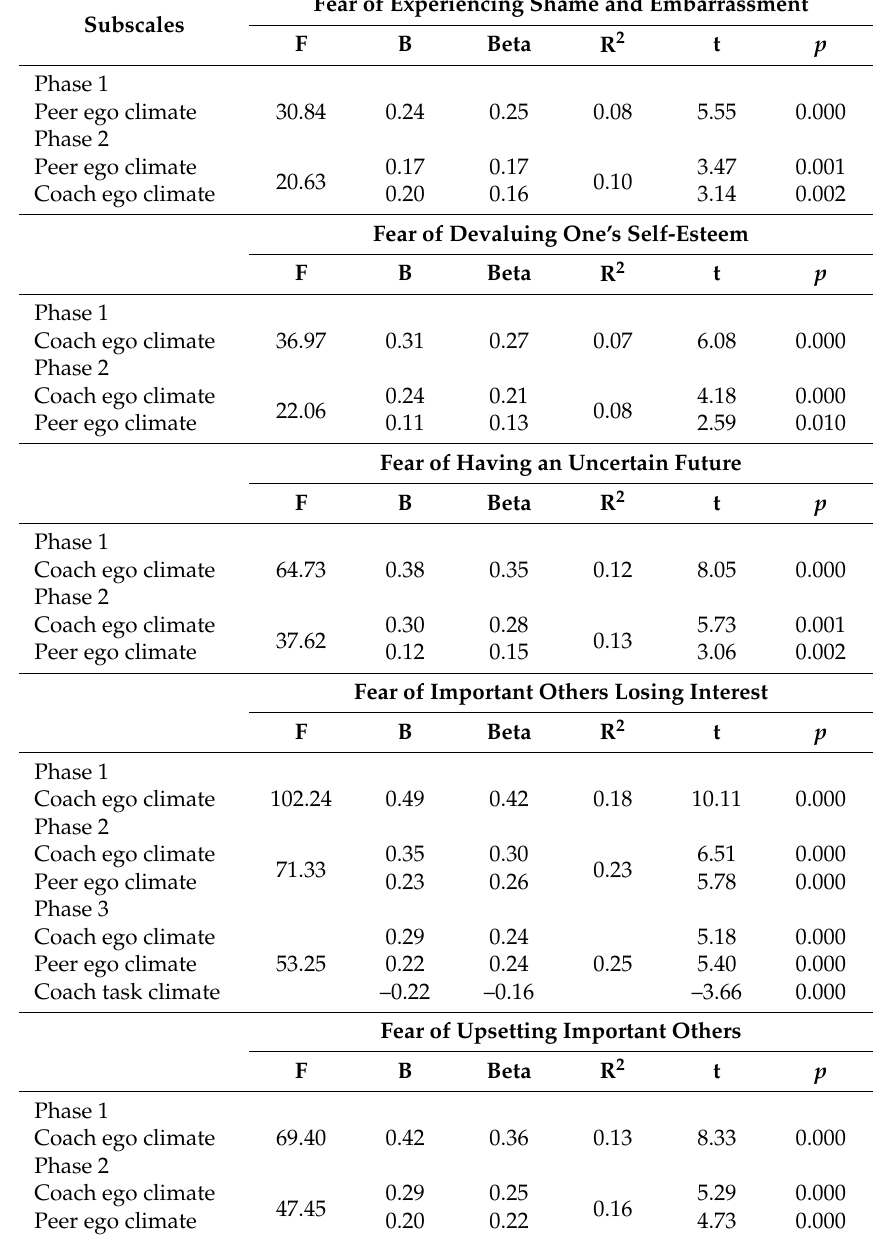
Table 3. Linear regression analysis. Predictive subscales of the PMCSQ-2, the PeerMCYSQ, and the PFAI variable